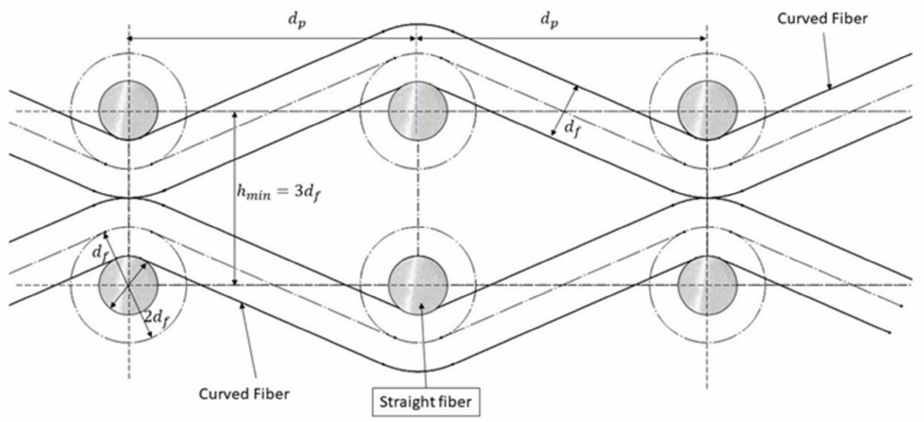
Figure 9. Description of parameters for closely packed wire-mesh layers in stacking of inline